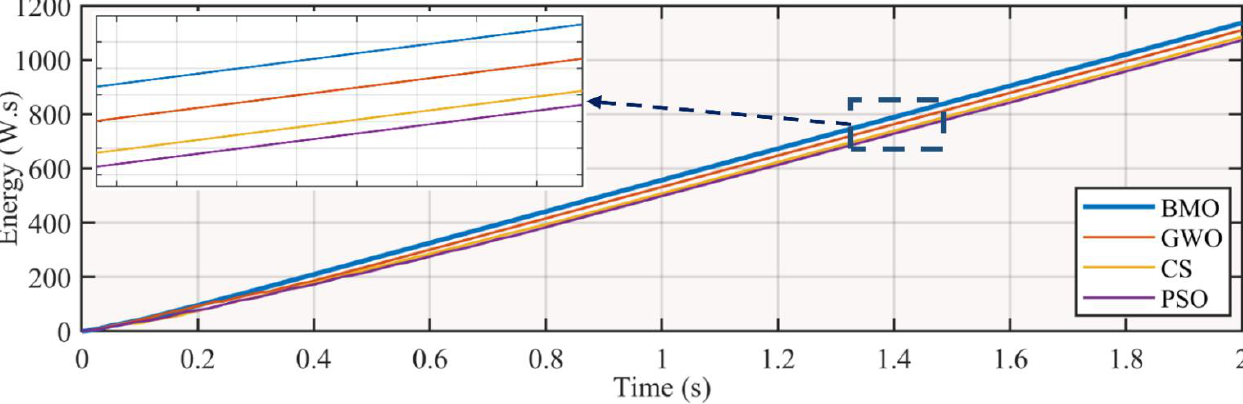
Figure 13. Competing techniques energy Case-1.